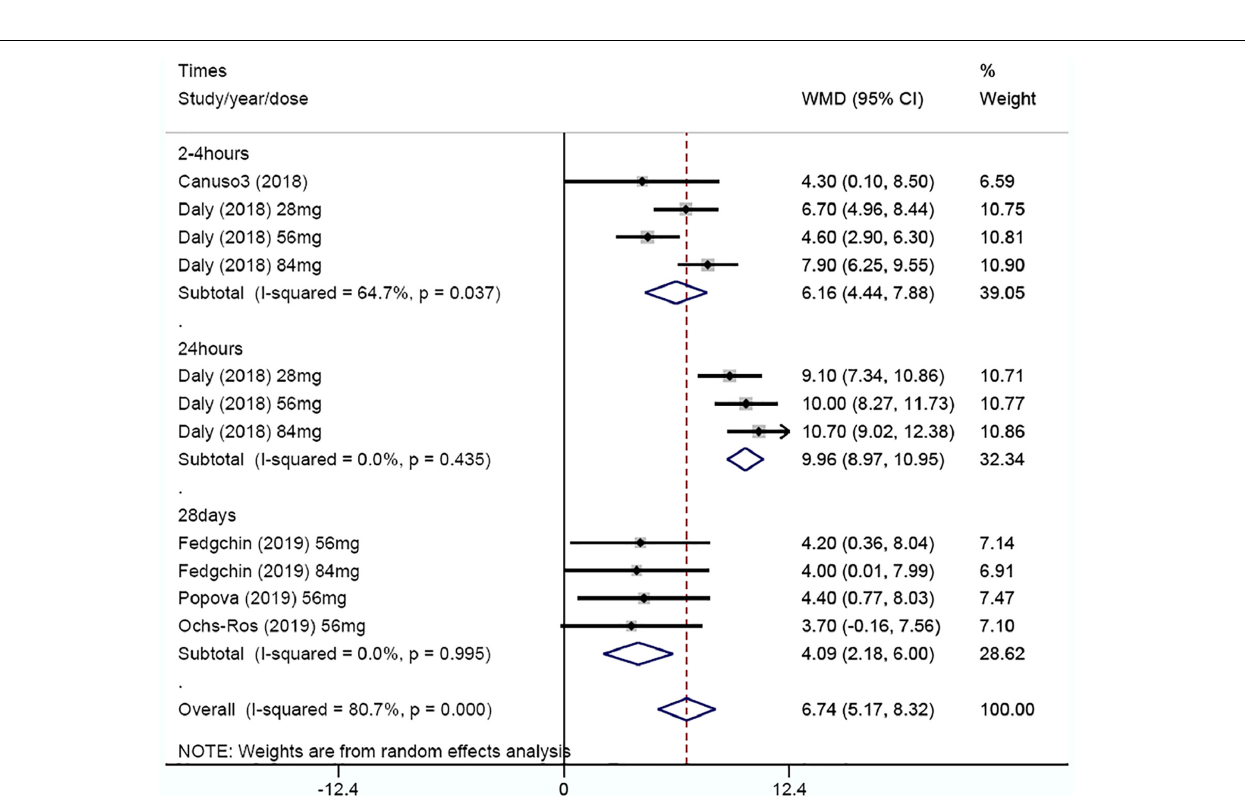
FIGURE 3 | Subgroup analysis of weighted mean difference in MADRS score decreased from baseline after 2–4 h, 24 h, and 28 day.